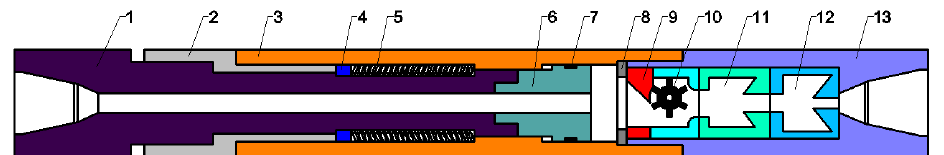
Figure 1. Structure diagram of the multi − source impact oscillation speed − increasing tool. 1—upper